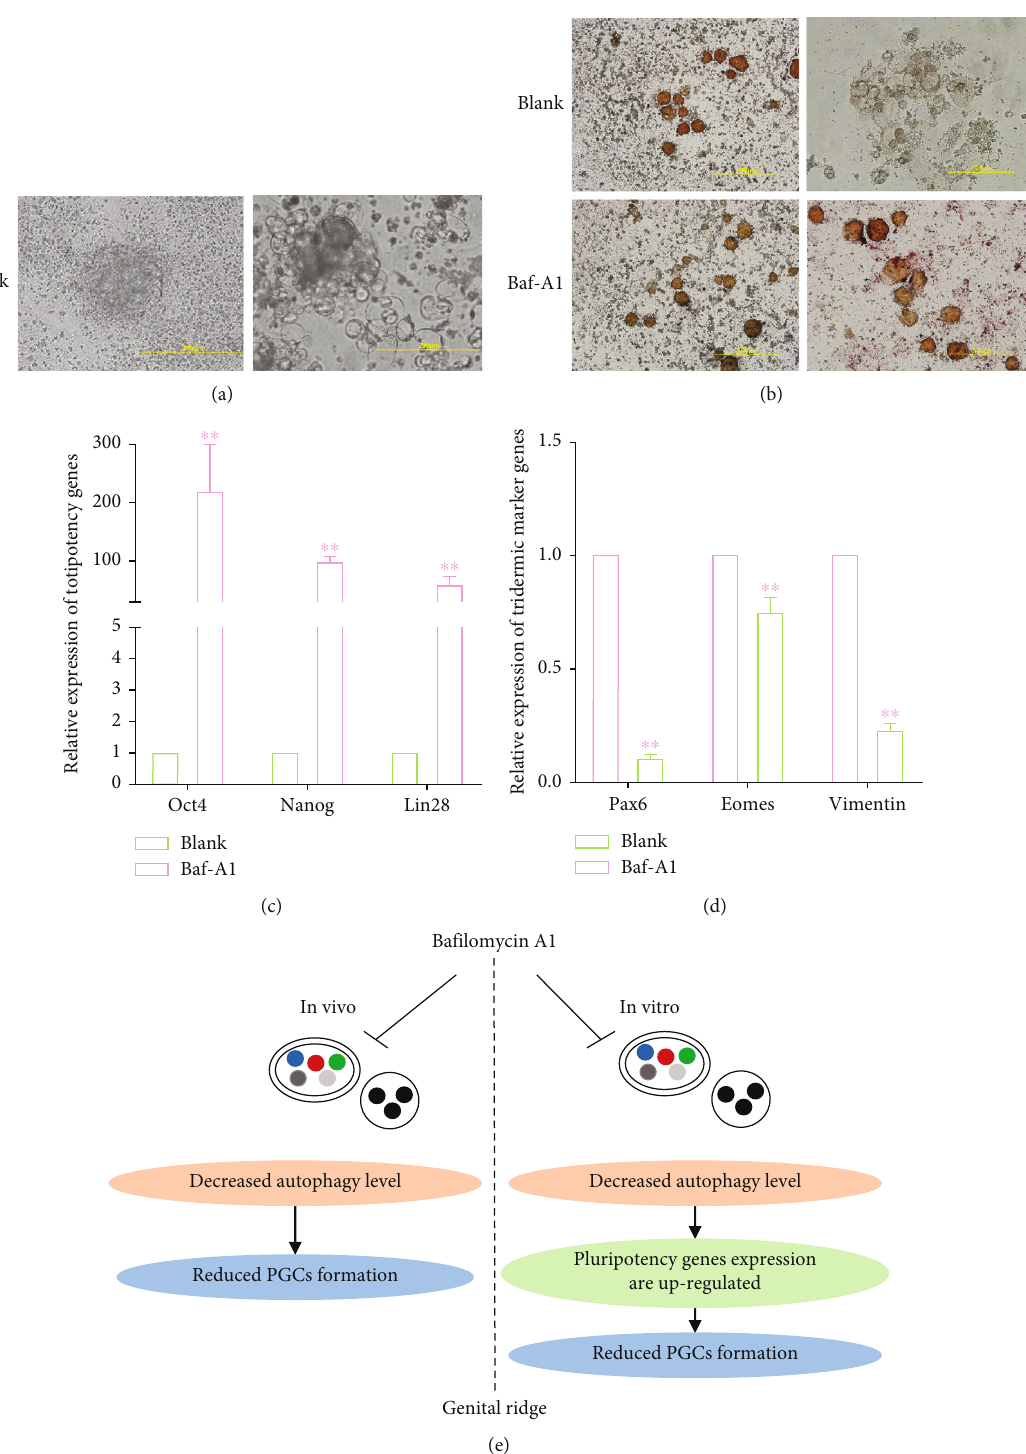
Figure 7: Inhibition of autophagy maintains the pluripotency of ESCs. (a) Formation of embryonic body in vitro in the absence of LIF. Scale bars = 200 μ m. (b) ESCs clones were stained using an alkaline phosphatase kit. Scale bars = 200 μ m. (c, d) The expression of pluripotency genes and tridermic marker genes in ESCs were detected by qRT-PCR. (e) A schematic diagram depicting how autophagy regulates PGCs formation in